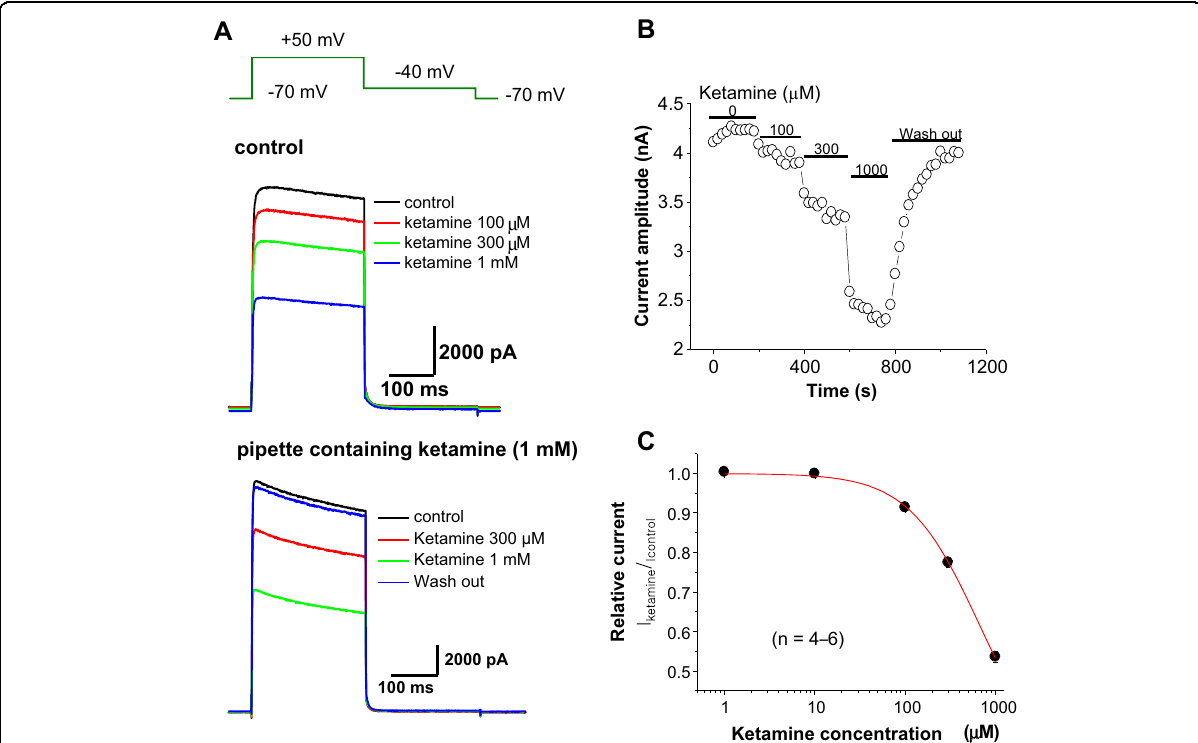
Fig. 4 Inhibition of Kv1.5 by ketamine. a (upper) Representative Kv1.5 current tracings elicited by voltage steps shown in the fi gure inset in the absence and presence of ketamine (100, 300, and 1000 µM); lower, Representative Kv1.5 current tracings recorded with the pipette containing ketamine (1000 µM) in the absence and presence of bath ketamine (100, 300, and 1000 µM). b Kv1.5 current amplitudes at + 50 mV are plotted against time. The period of application of various concentrations of ketamine is indicated as solid bars. c CRCs of ketamine-induced Kv1.5 inhibition. N in parentheses indicates the number of cells